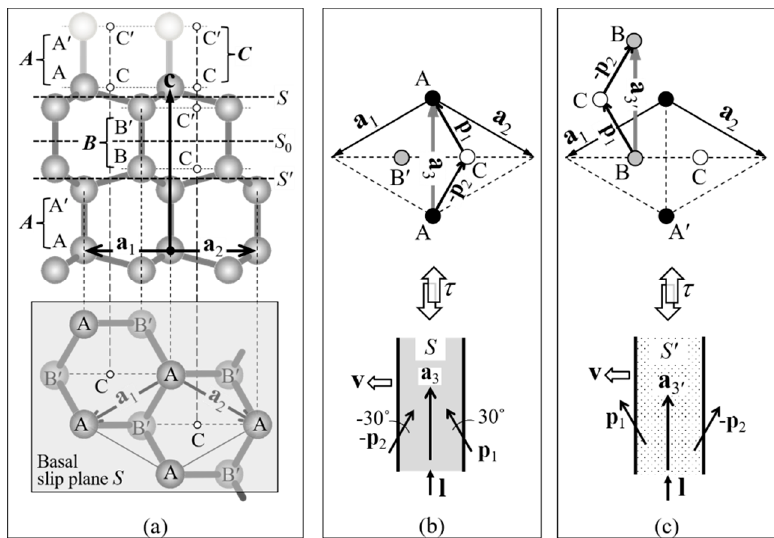
Figure 4. Basal slip system. ( a ) (Top) Glide set S (and S ′ ) and shuffle set S 0 for the basal slip system in I h . (Bottom) Top view showing the relative position of the atoms just above and below the slip plane S . ( b ) An extended dislocation on the slip plane S , with the Shockley partials p 1 and − p 2 dissociated from a right-handed screw dislocation a 3 . Glide motion in the direction v results in the two-step displacement of the top half above S by − p 2 followed by p 1 relative to the bottom half. ( c ) The same as (b) but with the exchanged arrangement of the partials on the slip plane S ′ .